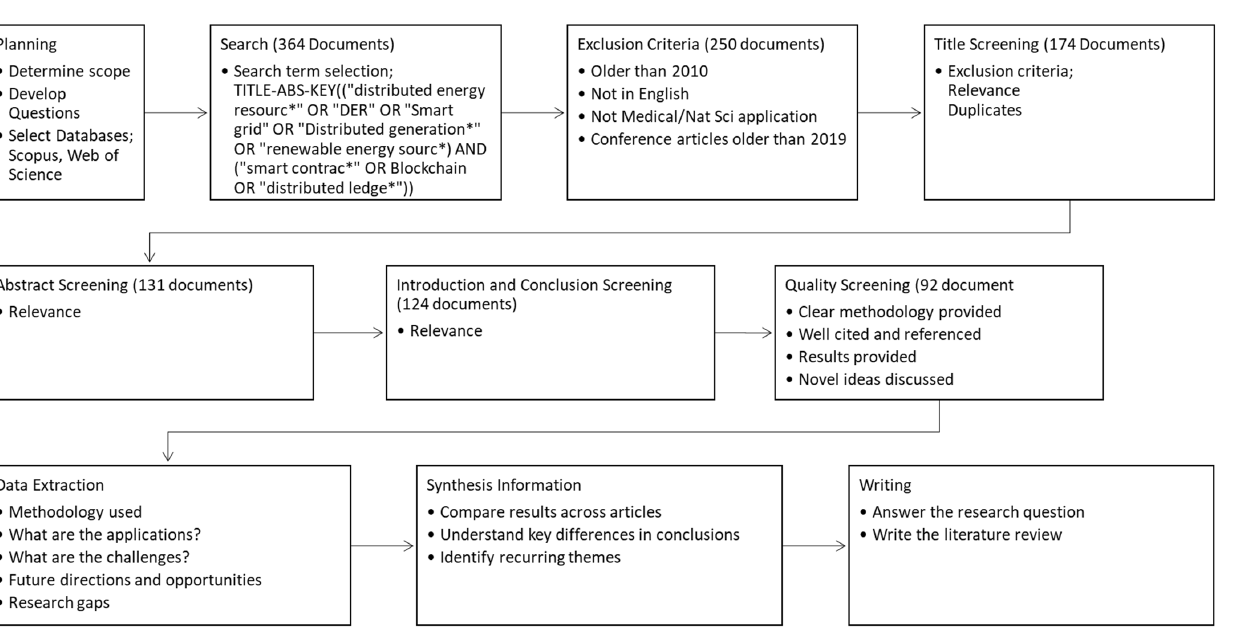
Figure 2. The methodology followed to conduct this systematic literature